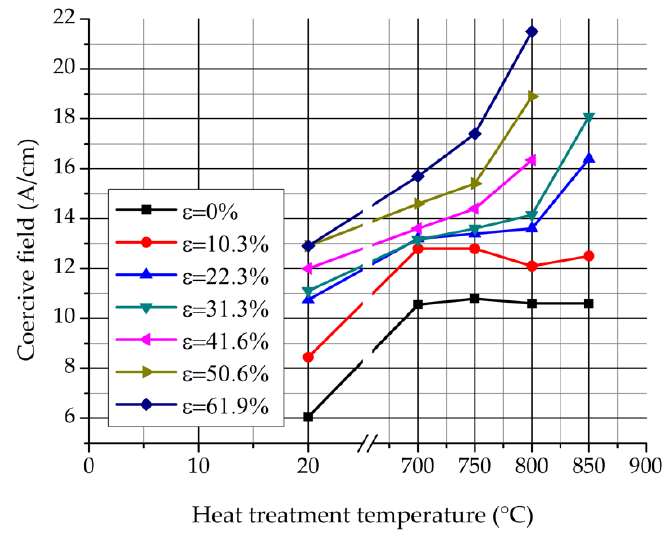
Figure 15. Values of the coercive field in function of the heat treatment temperature.